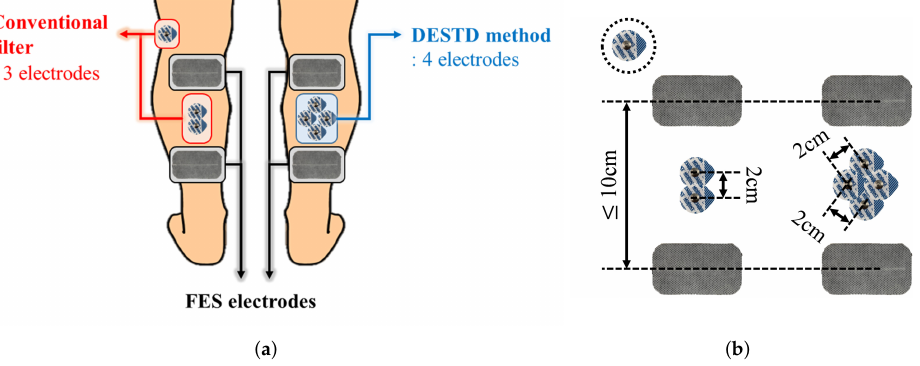
Figure 4. Electrode attachment positions for comparative data analysis: ( a ) Comparison of electrode attachment positions between conventional filter and DESTD method and ( b ) inter-electrode distances for each